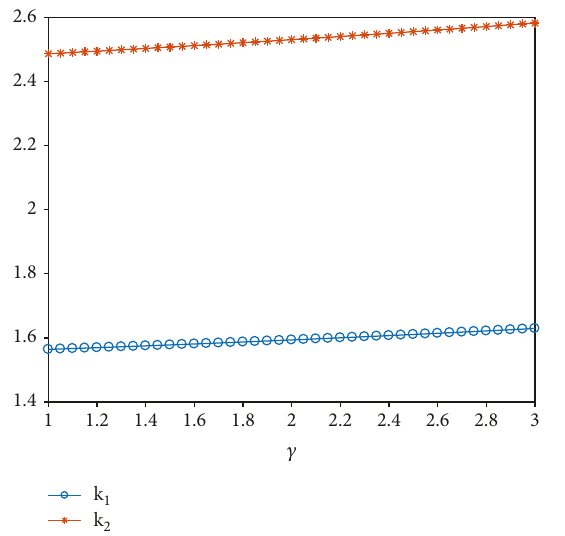
Figure 1: The impact of γ onto the span of the feasible region for contract.